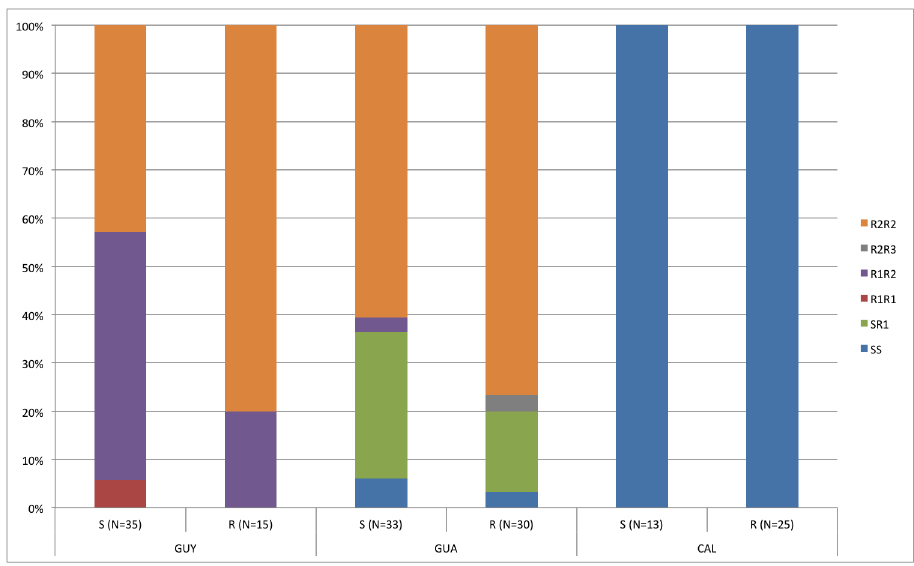
Fig 1. Cumulative histogram of genotype proportions per population and phenotype (S: susceptible, R: resistant). Number of individuals are also mentioned (N). Based on the description of Linss et al. [29], four alleles were obtained ‘ 1016V + 1534F ’ called S, ‘ 1016V + 1534C ’ (1534 kdr ) called R1, ‘ 1016I + 1534 C ’ referred to as R2 (1016 kdr +1534 kdr ) and ‘ 1016I + 1534 F ’ referred to as R3 (1016 kdr ).